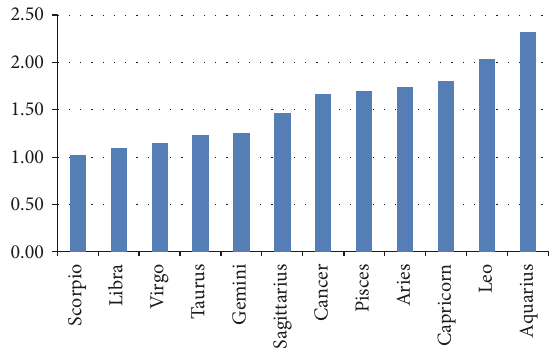
Figure 2: Percent frequency of complications during phacoemulsi fi cation per sign (sum of waxing and waning moon, by frequency): least complications in Scorpio, most common in